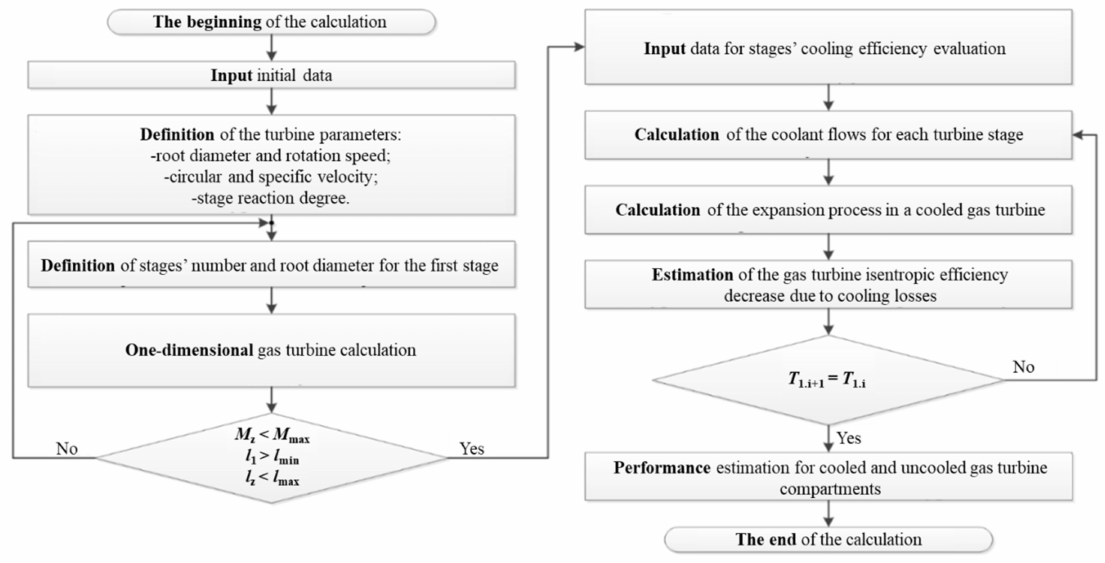
Figure 6. Cooled turbine analysis